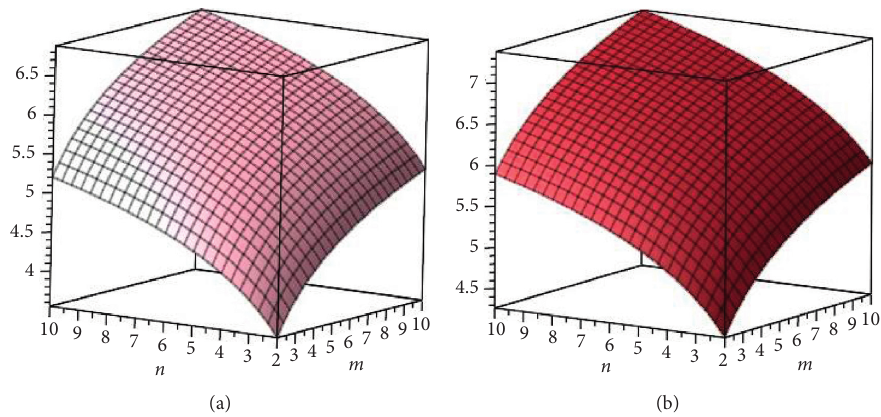
Figure 7: (a) The atom bond connectivity entropy; (b) the geometric arithmetic entropy.